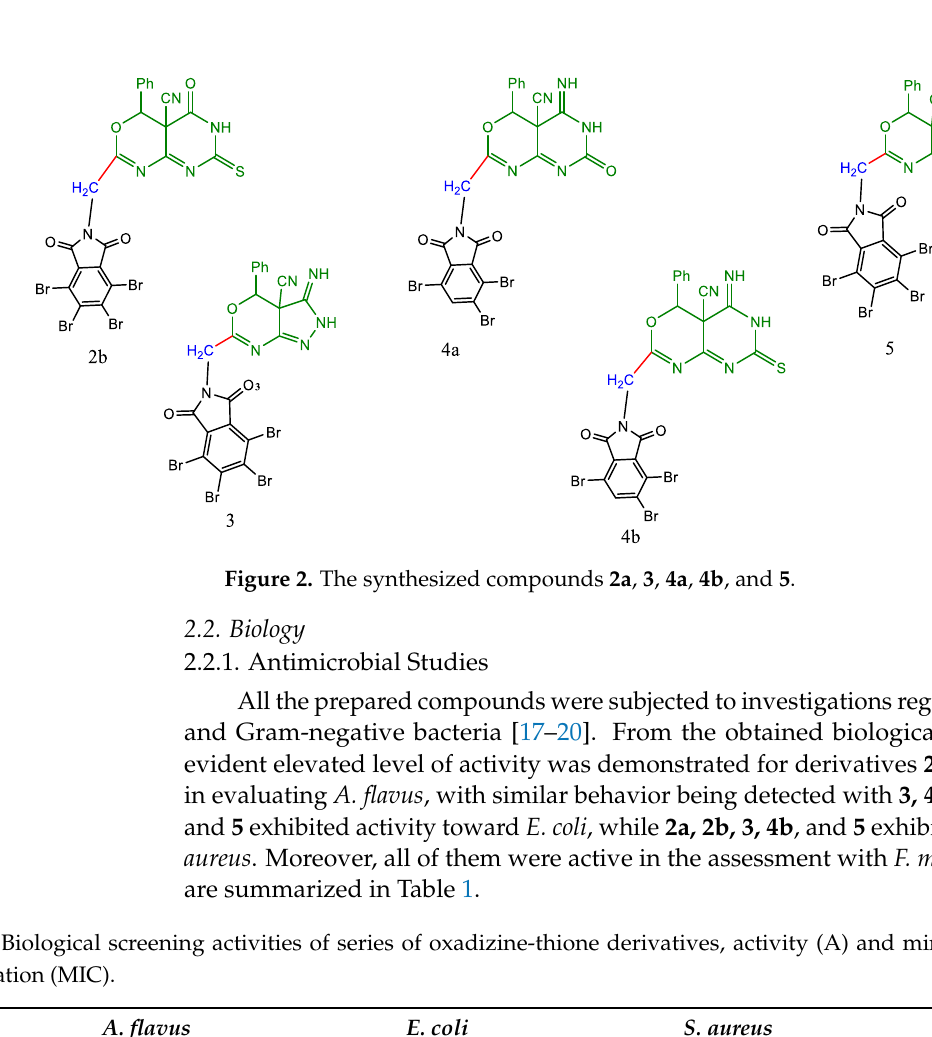
Table 1. Biological screening activities of series of oxadizine-thione derivatives, activity (A) and minimum inhibitory concentration (MIC). A. flavus E. coli S. aureus F. Compound Number